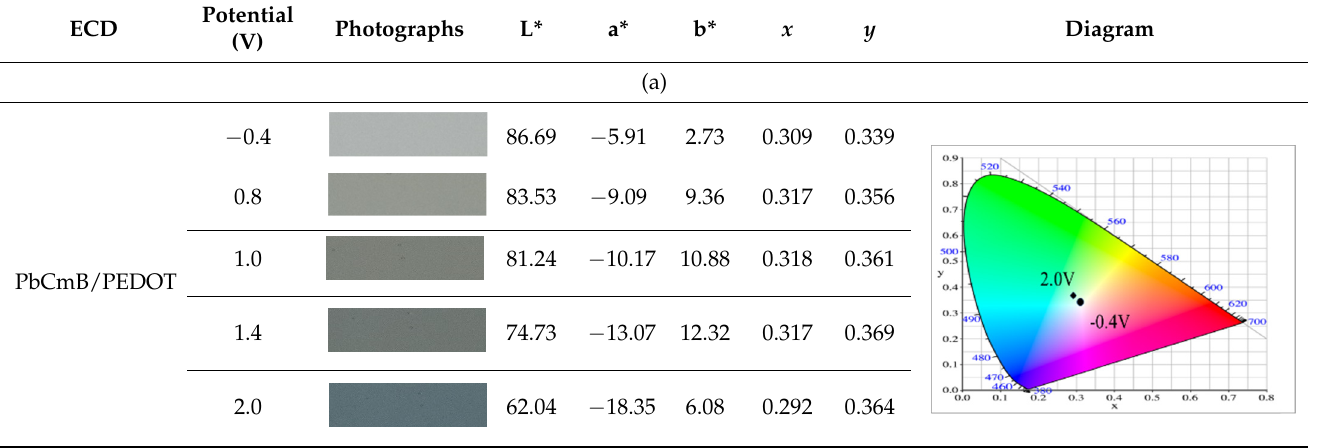
Table 5. Electrochromic photographs, colorimetric values (L*, a*, and b*), CIE chromaticity values ( x , y ), and diagrams of ( a ) PbCmB/PEDOT, ( b ) P(bCmB- co -bTP)/PEDOT, ( c ) P(bCmB- co -dbBT)/PEDOT, and ( d ) P(bCmB- co -TF)/PEDOT ECDs at different potentials.